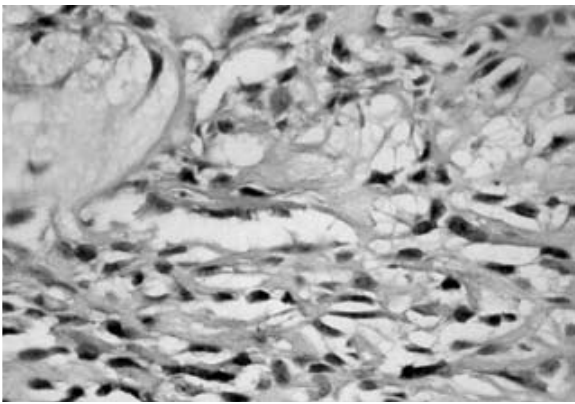
Figura 1 – Imunomarcação para p53 em células estreladas (400x)